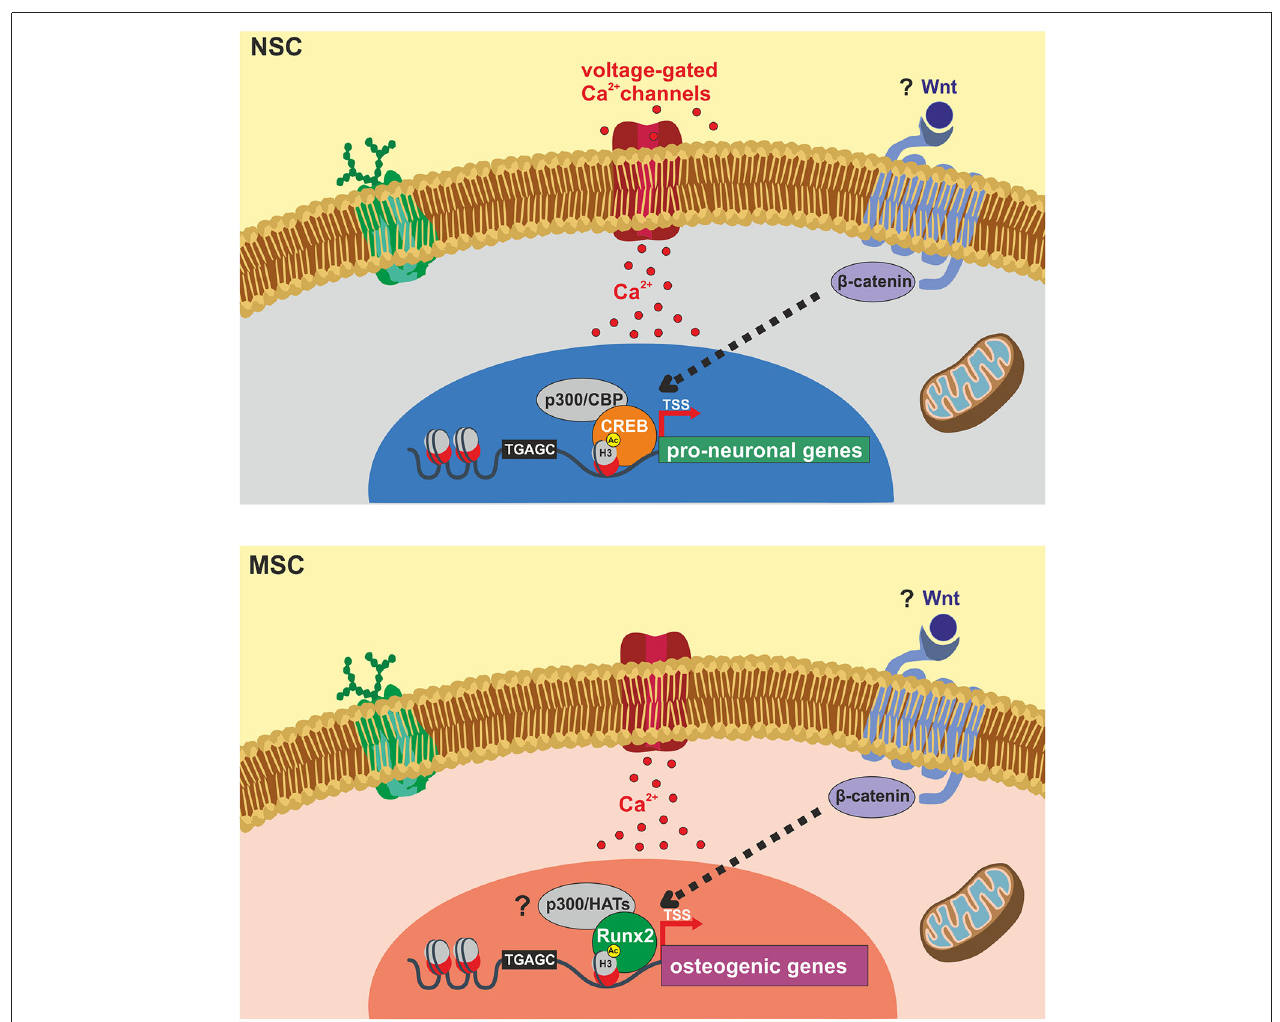
(iii) enhanced histone 3 (H3) acetylation on lysine 9 (H3Ac) of pro-neuronal gene promoters (i.e., NeuroD1 and Neurogenin1 ). In MSCs ELFEF-induced up-regulation of bone-related genes has been also linked to intracellular Ca 2 + signaling and enhanced expression of the transcription factor Runx2 which is known to bind the regulatory sequences of osteogenic genes promoting their expression. Question marks indicate putative common molecular targets of ELFEFs in NSCs and MSCs including: (i) Wnt/ β -catenin signaling regulating pro-neuronal and osteogenic gene expression at transcriptional and epigenetic levels; (ii) activation of p300 or other HATs by Runx2, resembling the pCREB/CBP pathway activated by ELFEFs in hippocampal